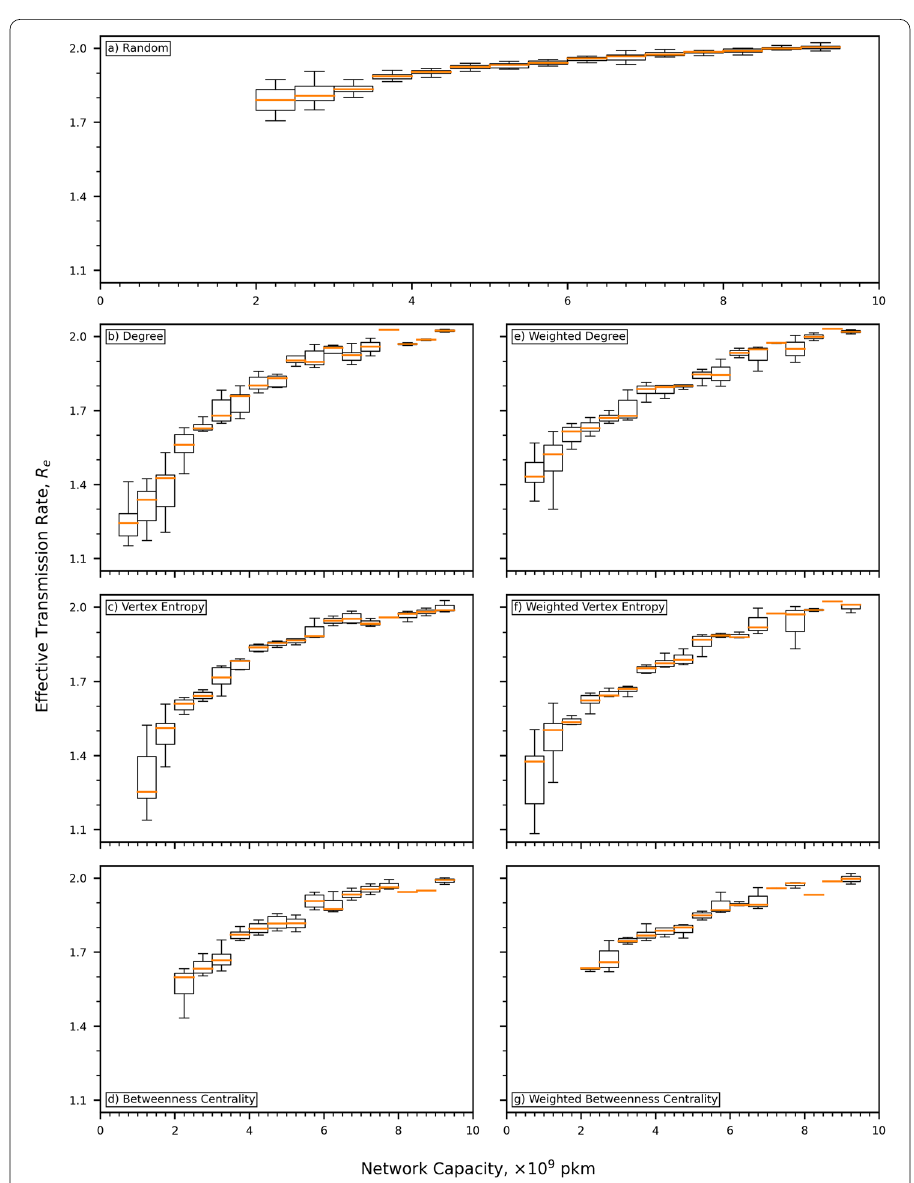
Fig. 7 Boxplots of effective transmission rate stratified by capacity for random node removal and each of the targeted node removal regimes. a Shows the random removal scenario, b – d show the unweighted versions of degree, VE and BC respectively, and e – g show the weighted versions of those regimes. At capacities below 3.0 × 10 9 pkm there is considerable variability in the data, where it is available. The degree-based regimes exhibit the highest degree of variability. Above 3.0 × 10 9 pkm the VE and BC-based regimes generally display similar levels of